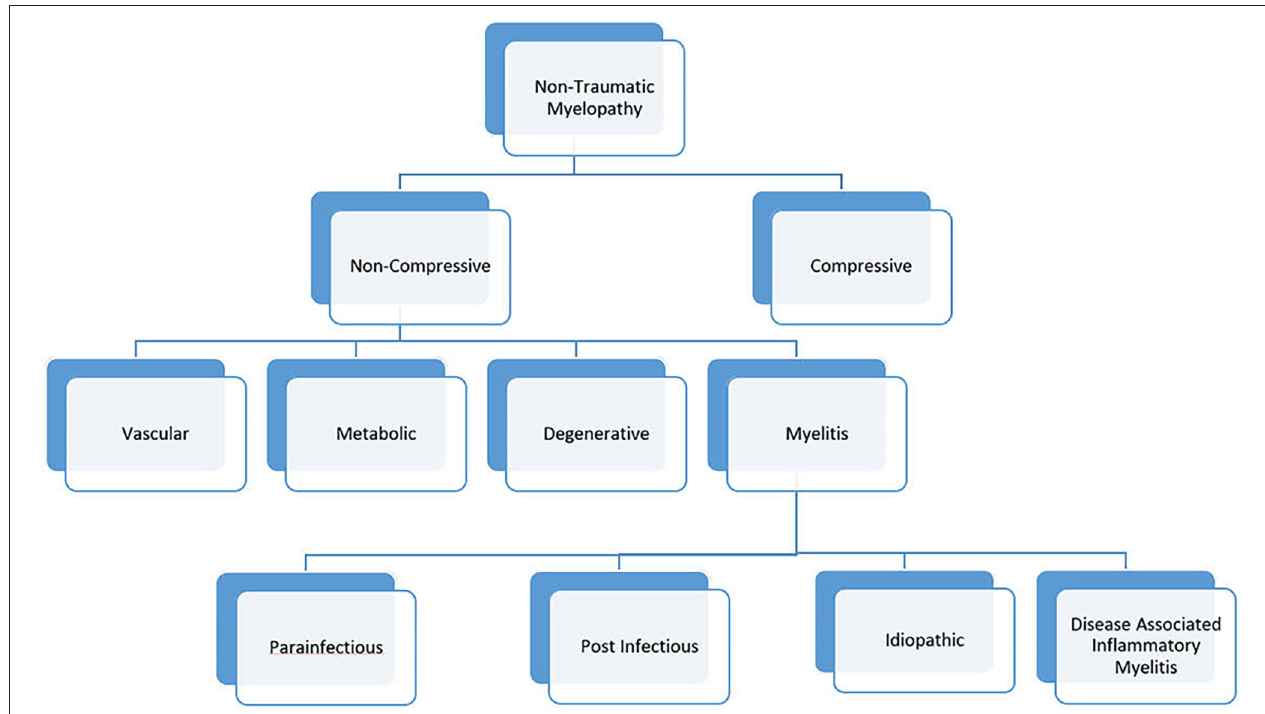
FIGURE 1 | Etiologic classification of myelopathies. In this proposed framework, the term “myelitis” is used to define any clinical presentation of myelopathy with evidence of inflammation on imaging or CSF